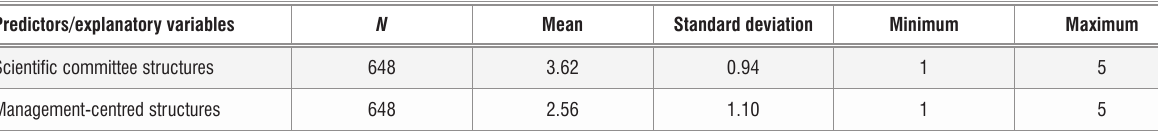
Summary of means Predictors/explanatory variables N Mean Standard deviation